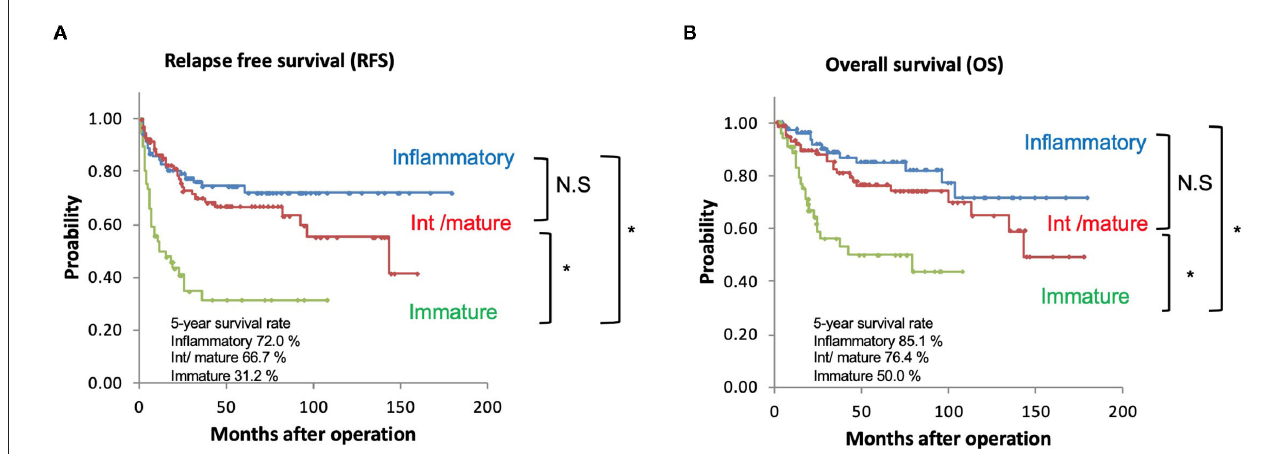
FIGURE 3 | (A) Kaplan-Meier curves of recurrence-free survival based on the SP. (B) Kaplan-Meier curves of overall survival based on the SP. * p < 0.001; NS, not significant.